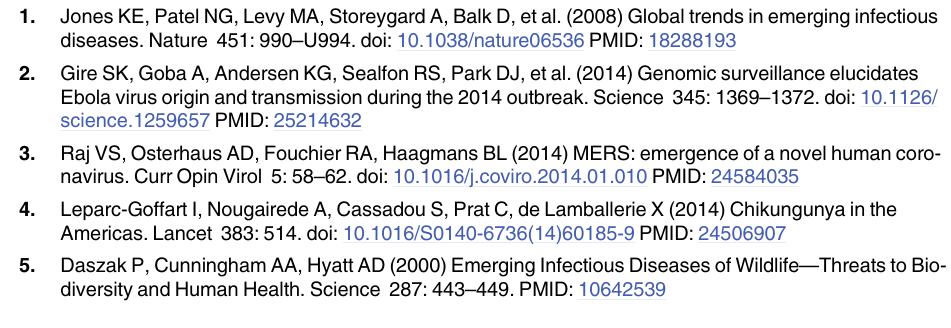
S1 Table. Primers and probes for qRT-PCR quantification of RNA copies. S2 Table. Summaries of the genome reference libraries. S3 Table. PathoScope parameter values used in this